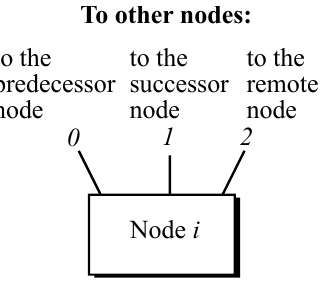
Figure 6. Heawood graph node with ports going to their neighboring nodes.